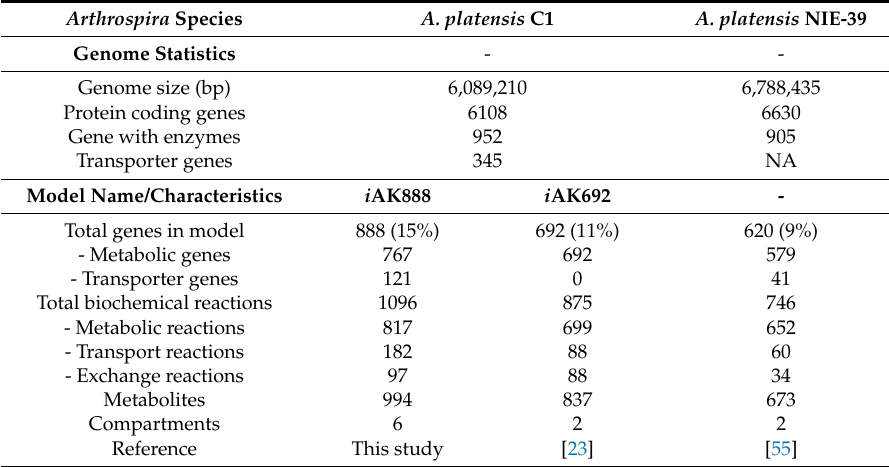
Table 2. Comparison of network model characteristics of A. platensis